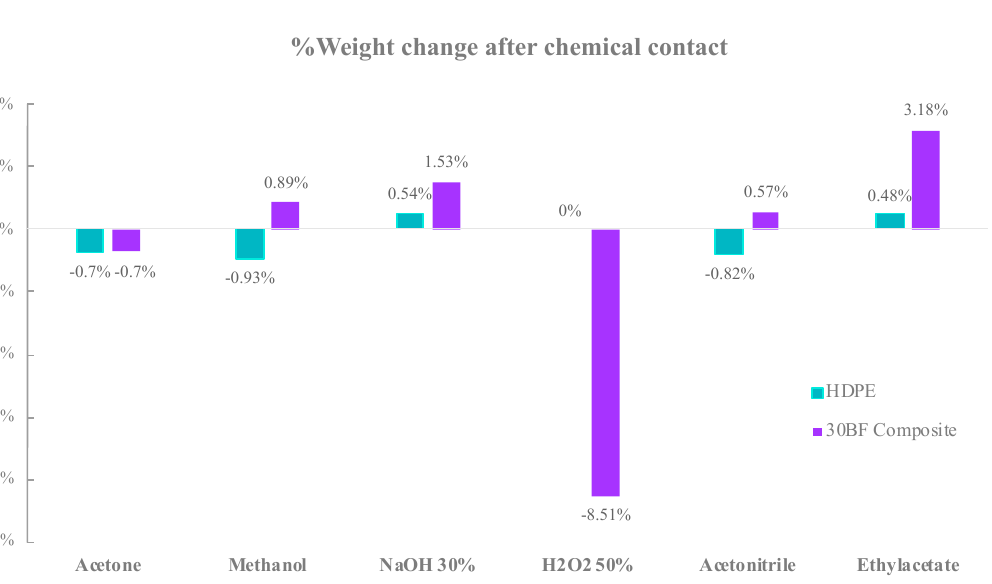
Figure 5. Relative weight change of HDPE and composite samples following 24 h of chemical contact.